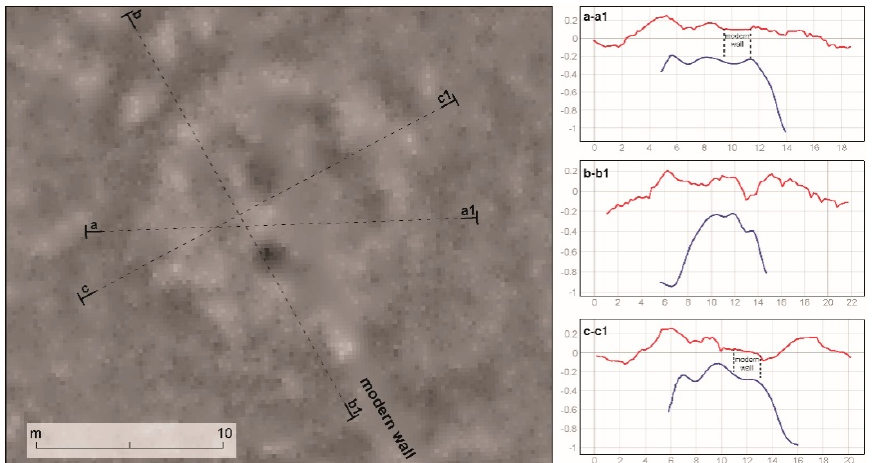
Figure 4. Simple Local Relief Model visualization of feature 8 ( left ) and interpreted profiles ( right ) (radius = 20 px). Dotted lines and associated letters a-a1, b-b1 and c-c1 indicate the position of the profiles. The topographic surface profiles from ALS data are in red while the profiles of the underlying stone cap from GPR data are in blue.